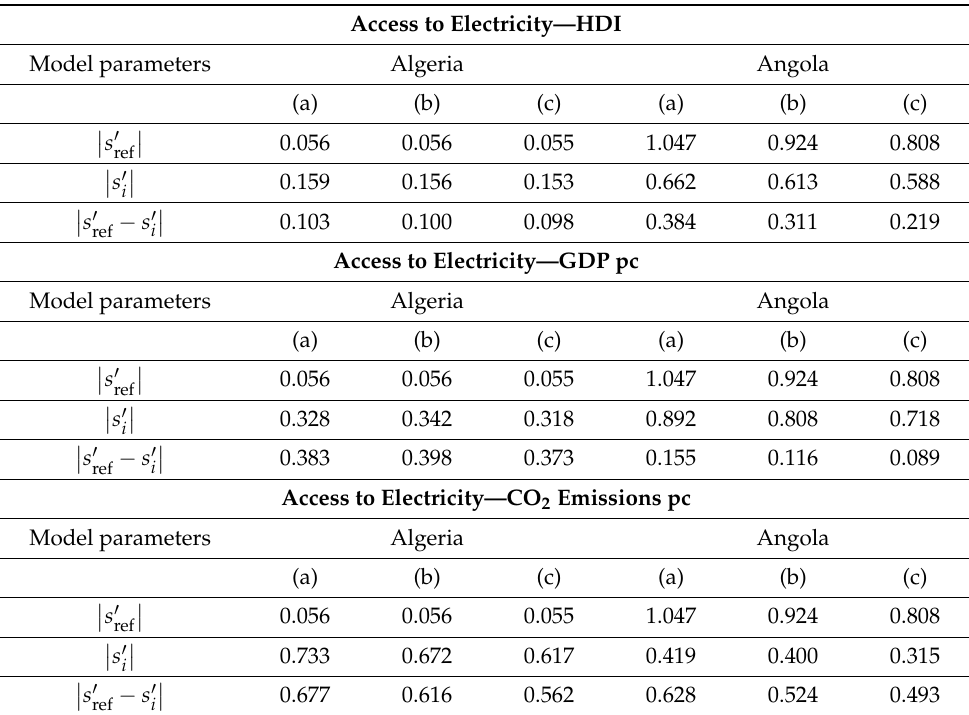
Table 8. Model components for the determination of the relative degree of grey incidence r ref − i for two selected African countries. Source: own